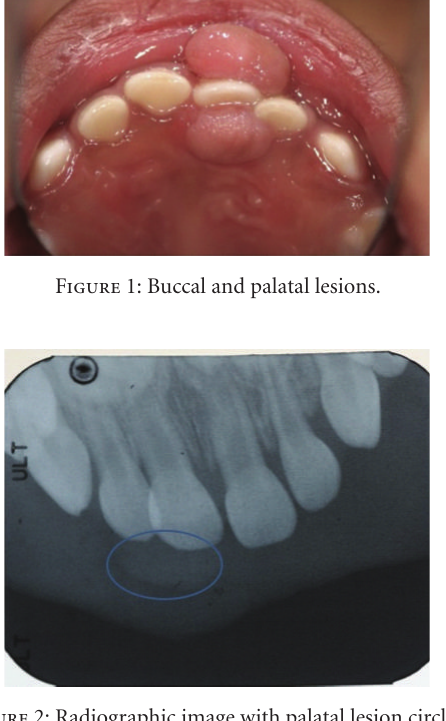
Figure 2: Radiographic image with palatal lesion circled.